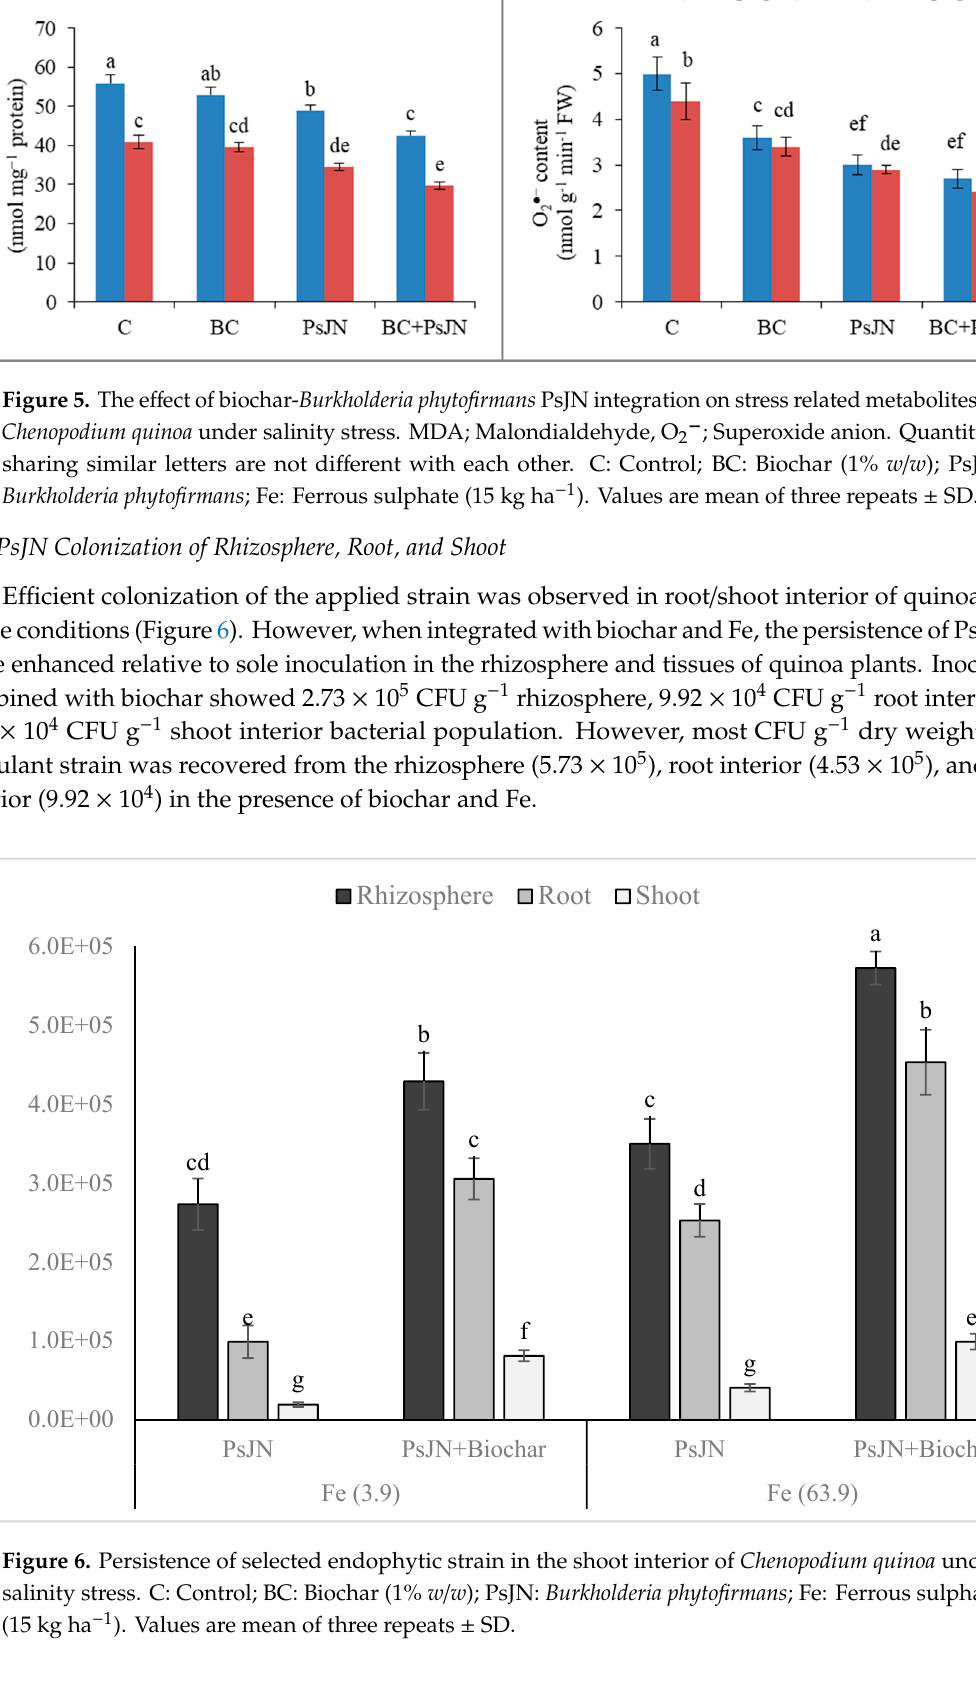
(15 kg ha − 1 ). Values are mean of three repeats ± SD.